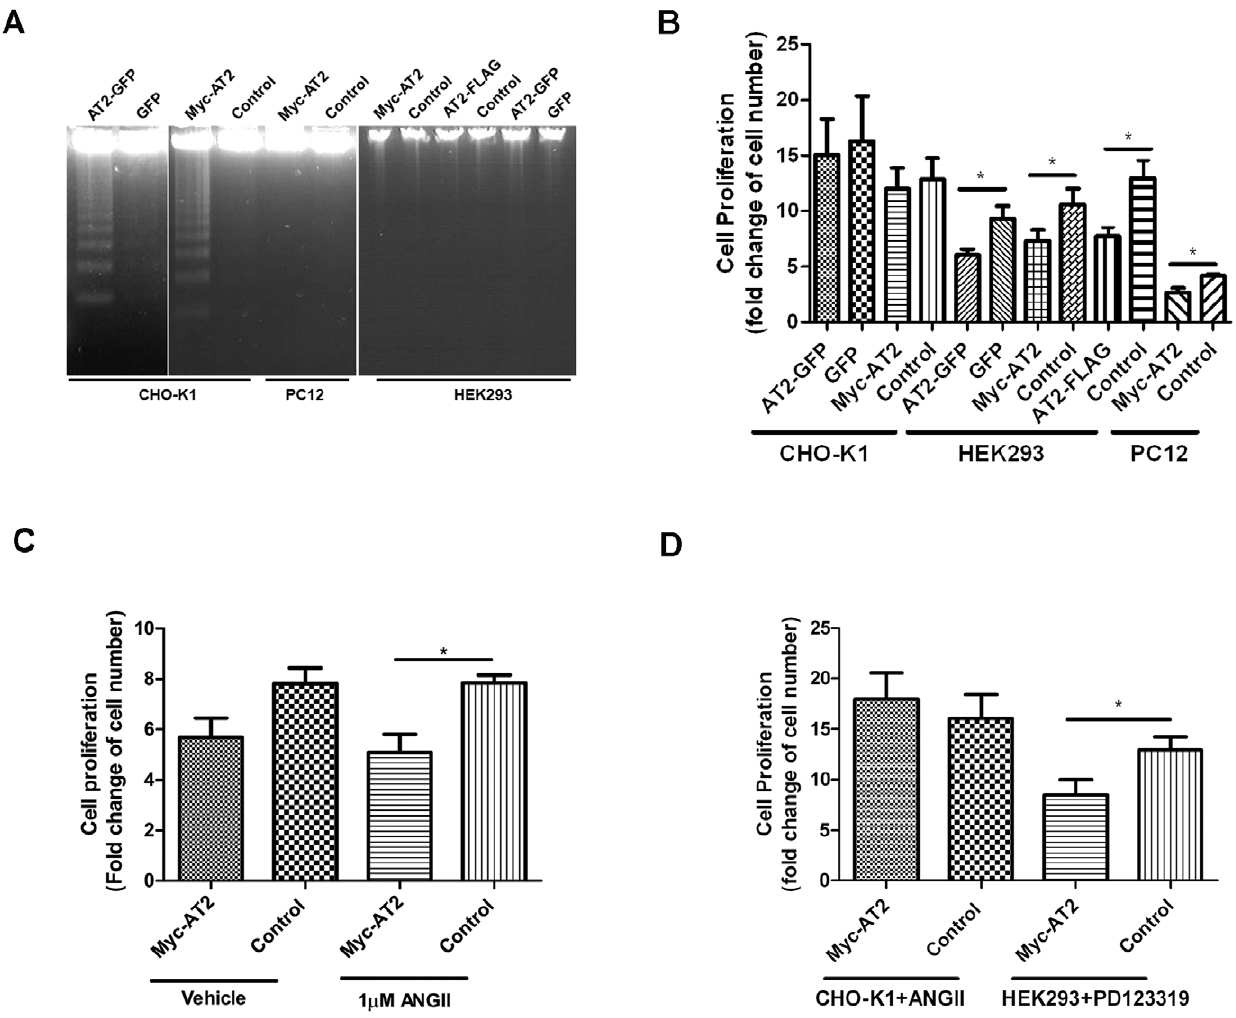
Figure 4. Ligand-independent constitutive activities of epitope-tagged AT2 receptors. (A) Serum starvation-induced DNA fragmentation. Stably transfected CHO cells (5 6 10 5 ), PC12 cells (5 6 10 5 ), and HEK cells (1 6 10 6 ) were cultured in serum-free medium for 72 hr. Genomic DNA was extracted and fractionated on 2% TAE agarose gel as described in Methods. (B) Cell proliferation analysis. Stably transfected CHO cells (1 6 10 5 cells), PC12 cells (5 6 10 5 cells) and HEK293 cells (5 6 10 5 cells) were seeded on 60-mm dishes and cultured for 5 days. (C) Stably transfected HEK293 cells (5 6 10 5 cells on 60 mm dish) were cultured for 5 days in the absence or presence of 1 m M ANGII. (D) Stably transfected CHO-K1 (1 6 10 5 cells on 60 mm dish) and HEK293 cells (5 6 10 5 cells on 60 mm dish) were cultured for 5 days in the presence of 1 m M ANGII or 10 m M PD 123319, respectively. Cell numbers were counted using Beckman coulter Vi-cell TM XR cell viability analyzer. Cell proliferation were expressed as fold change of cell number. Data shown is mean 6 SEM from 4 , 6 independent experiments. *indicates P ,